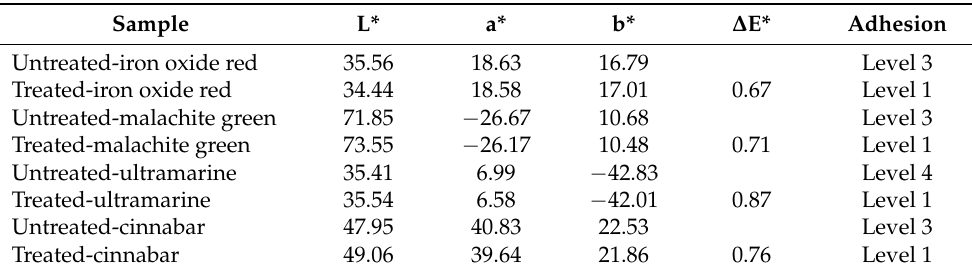
Table 1. Chromatic aberration and adhesion changes of untreated and treated portions of the sim ‐ ulated painted pottery Sample